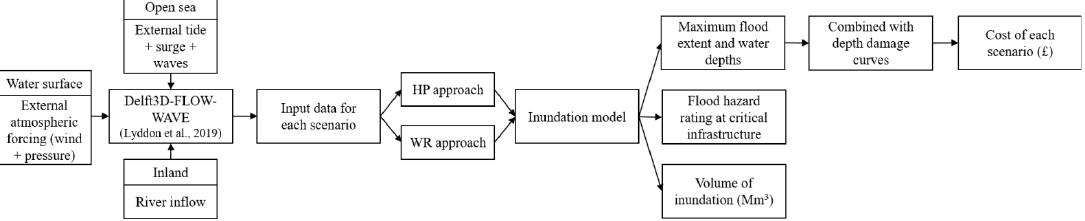
Figure 2. Model inputs and the process followed to propagate and quantify uncertainty in flood hazard assessments, and results that are presented in Section 3.